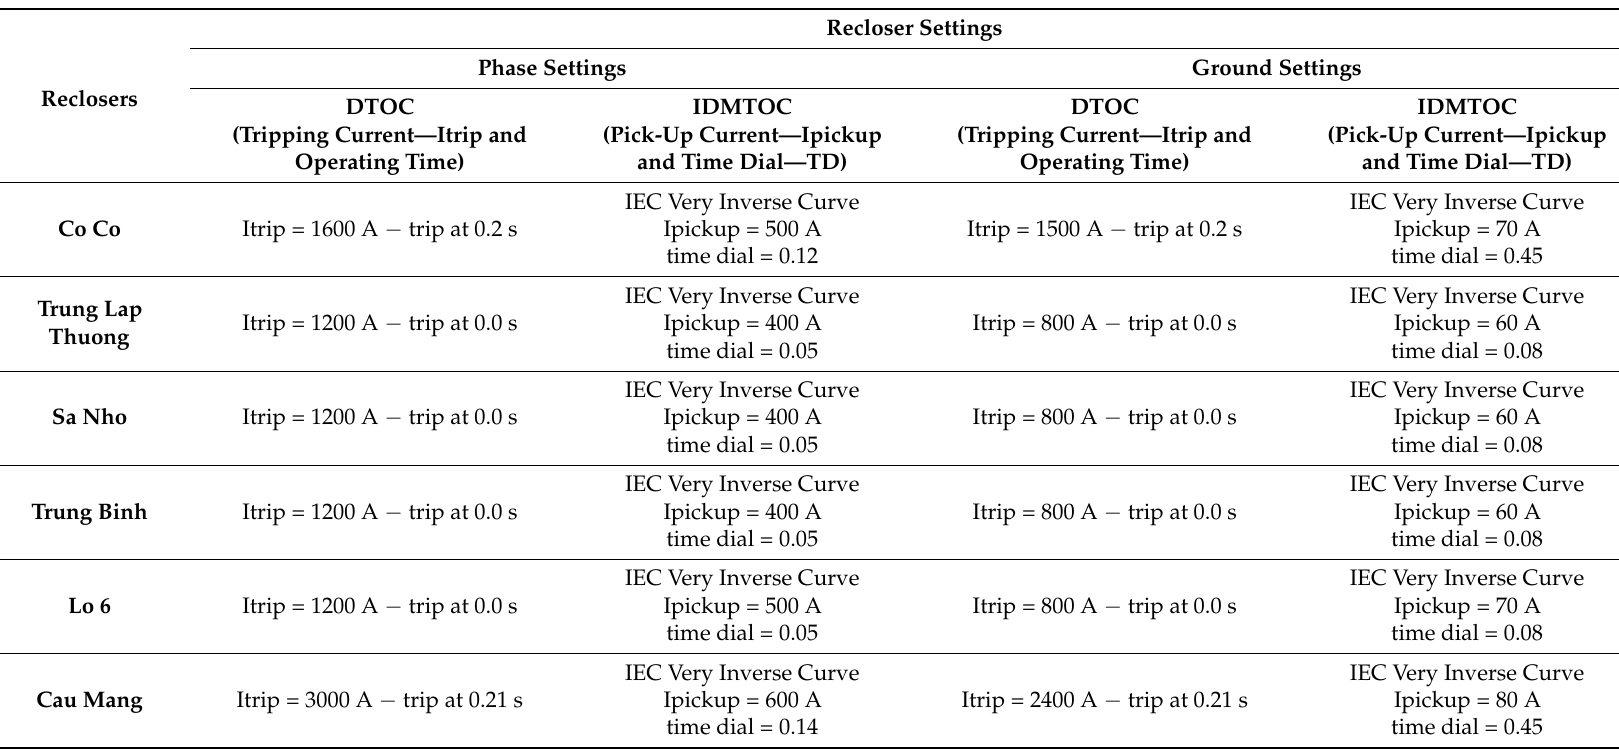
Table 9. Recloser settings in the BAU DUNG Distribution Network (the current transformer ratio of 1000/1 and the voltage transformer ratio of 22 kV/100